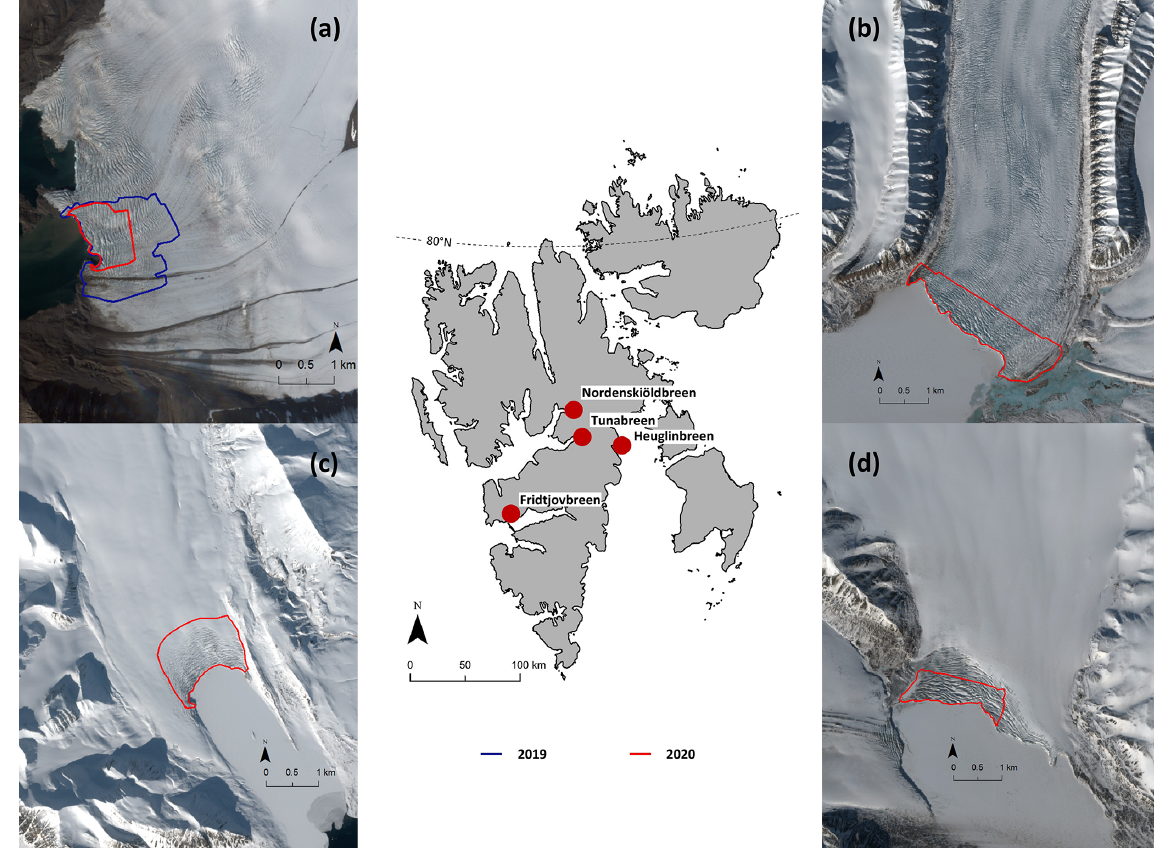
Figure 1. Field sites: map of Svalbard with marked locations of the investigated tidewater glaciers (red dots). Additionally, Sentinel-2 satellite images (ESA, 2020) of the glaciers Nordenskiöldbreen (a) , Tunabreen (b) , Fridtjovbreen (c) and Heuglinbreen (d) taken in the according week of fieldwork provide a closer look. The lines mark the mapped front area for each glacier in 2019 (blue) and 2020 (red). Table 2. Overview of the tidewater glaciers visited and the date of their UAV survey. Additionally, the size of the mapped area and DEM resolution, as well as the average height and length of roughness elements for a up-/down-glacier (cross-glacier) wind direction are listed. Glacier Date Location Area (km 2 ) Res. (mpx − 1 ) Height (m) Length (m) Nordenskiöldbreen